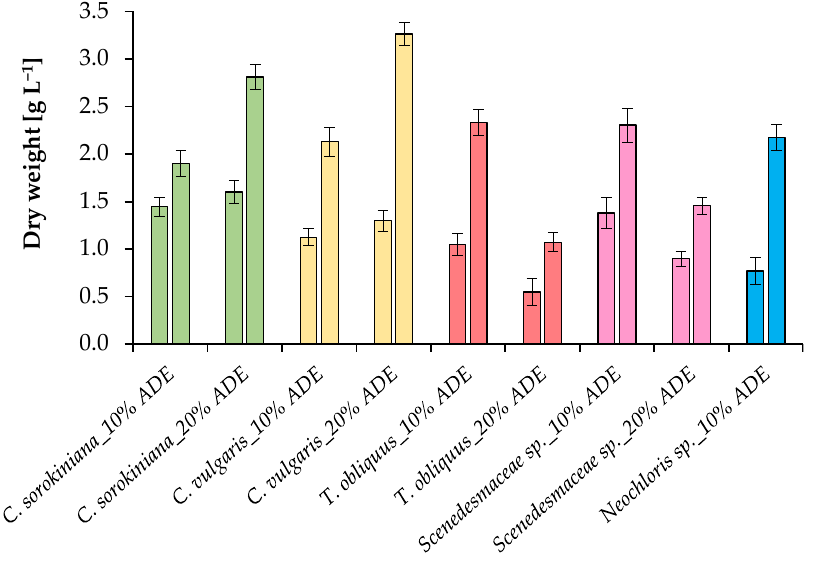
Figure 3. Growth characteristics of algal cultures: dry weight of microalgae cultured in 10% ADE (measured on 88 h and 256 h) and 20% ADE (measured on 136 h and 328 h). In the case of Neochloris sp. EE-K3, the growth values in 10% ADE were the lowest Table 2. Characteristics of tested microalgal strains when grown in ADE ‐ based media. compared to other strains. The strain EE-K3 did not grow when treated with 20% ADE, and dry weight of 2.17 ± 0.14 g L − 1 in experiments with 10% ADE (Figure